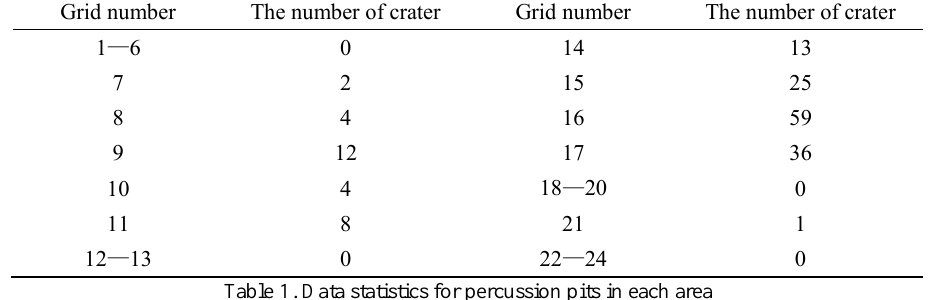
Table 1. Data statistics for percussion pits in each area